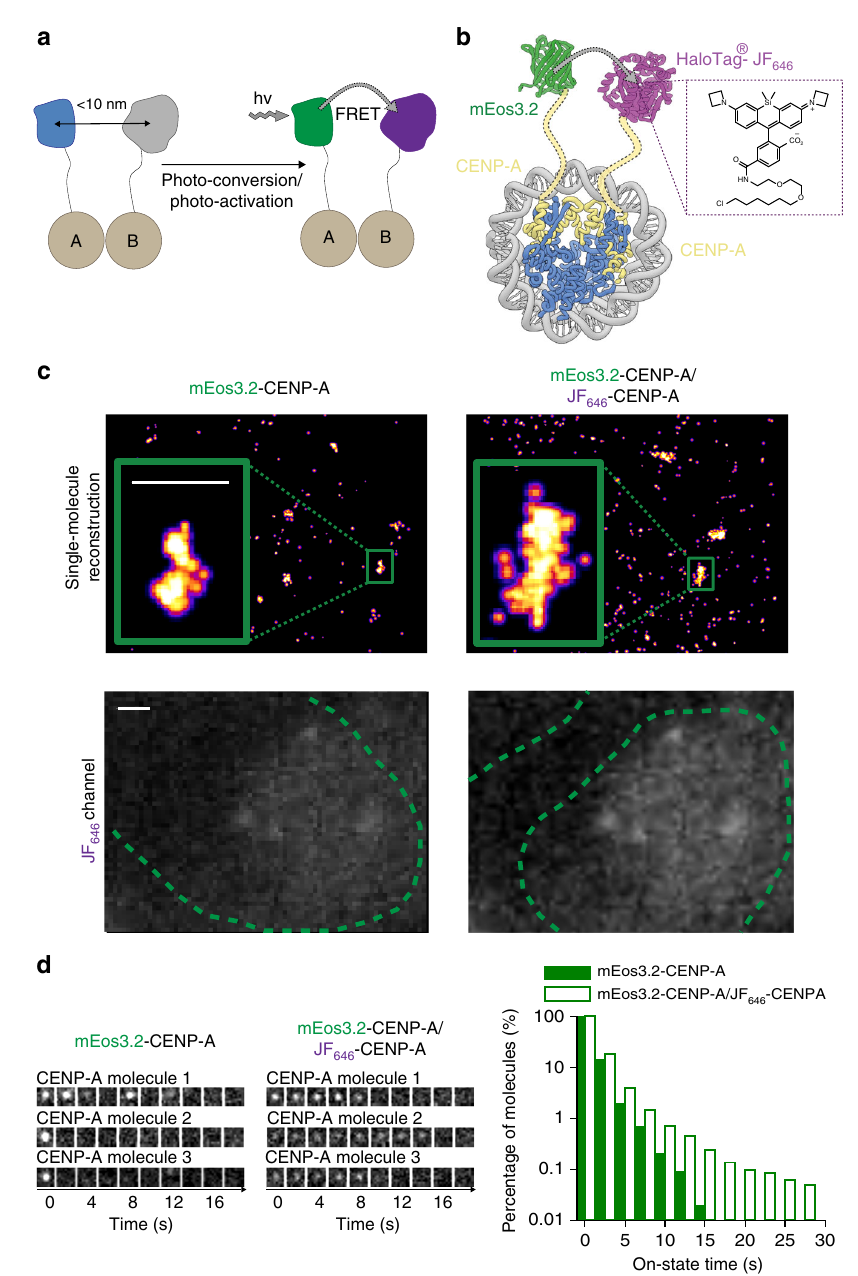
Fig. 4 mEos3.2 – JF 646 allows tracking of single CENP-A protein complexes. a Schematic of labeling one protein with a donor PM fl uorophore and a second protein with JF 646 such that FRET occurs when they are in close spatial proximity. b Tagging CENP-A with either mEos3.2 or the HaloTag protein in the same cell allows assembly of nucleosomes where FRET can be observed between mEos3.2 and JF 646 in the (CENP-A/Histone H4) 2 hetero-tetrameric core. c (top) Representative reconstructions of single mEos3.2-tagged CENP-A nucleosomes localized at centromeres (see inset) are shown in the absence or presence of JF 646 -labeled CENP-A. Scale bar = 500 nm. (lower) Images of the JF 646 dye show that the HaloTag-tagged CENP-A has been successfully labeled. Scale bar = 1 µ m. d Single mEos3.2-tagged CENP-A nucleosomes show decreased intensity and increased track length in the presence of JF 646 - tagged CENP-A. (left) Montages of three representative 500 ms exposure single-molecule traces (one image for every four frames) are shown in the absence or presence of the JF 646 -labeled CENP-A. (right) Histograms showing the percentage of molecules remaining with a particular on-state time (i.e., individual track length) after photo-conversion when performing sptPALM in mouse ES cells. Cells expressing mEos3.2-tagged CENP-A are compared with cells also expressing JF 646 -tagged